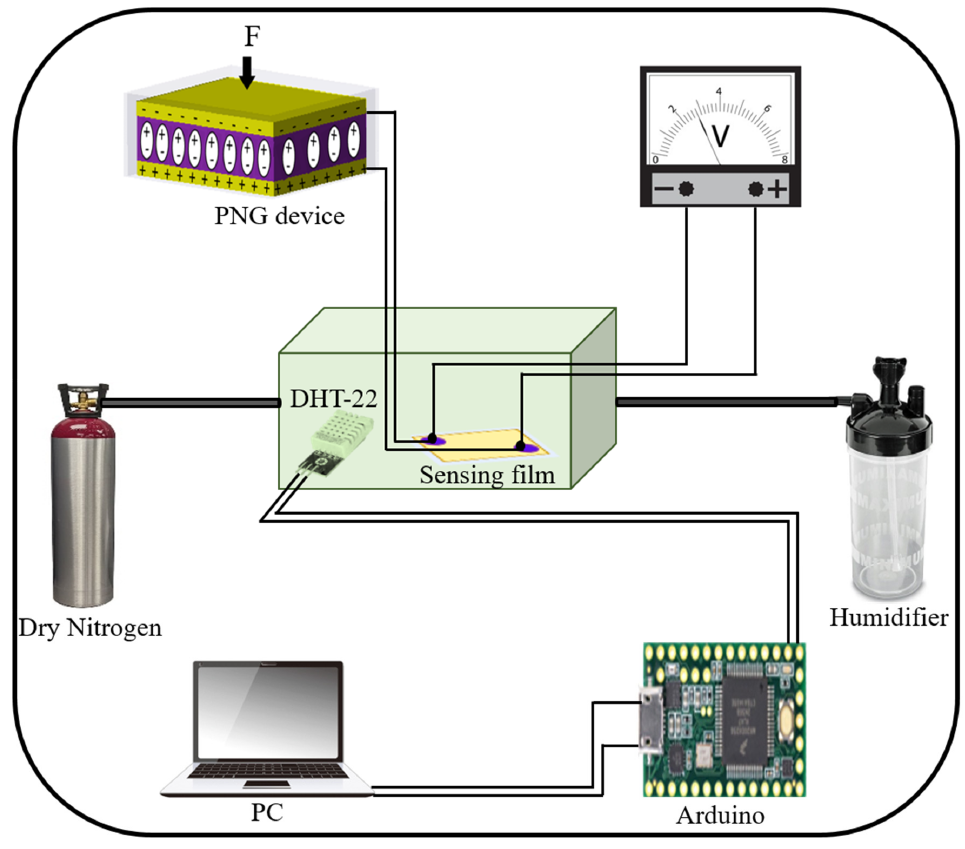
Figure 7. Block diagram of the self ‐ powered humidity testing and data acquisition setup.